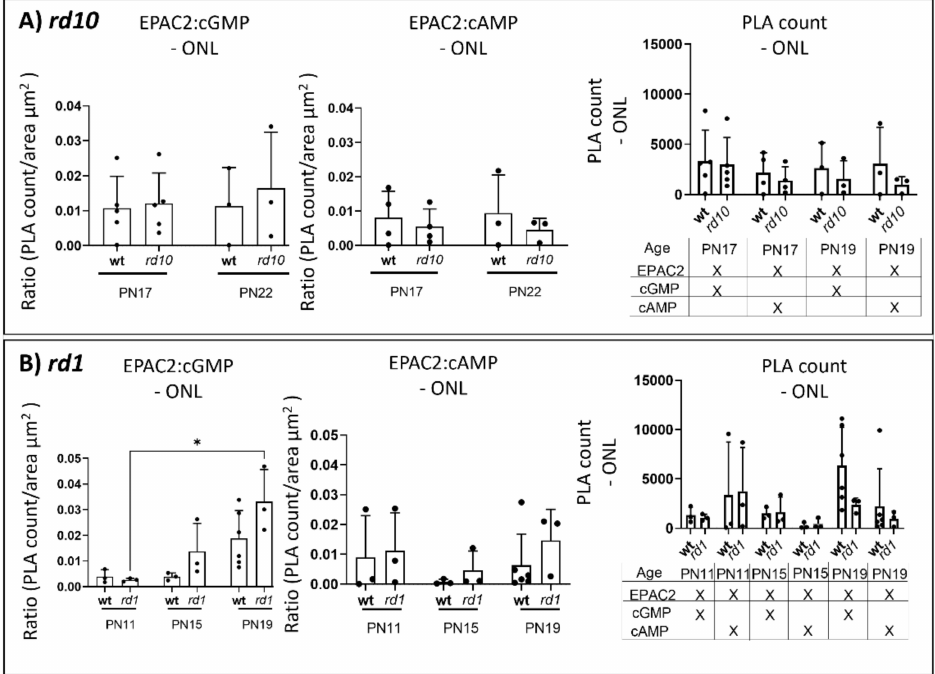
Figure 5. The extent of cGMP and EPAC2 proximity increases with time in the rd retina. Panel ( A , B ) gives PLA ratios (PLA counts over ONL area) and raw PLA counts for various situations: (left) proximity outcome between EPAC2 and cGMP (EPAC2:cGMP); (middle) proximity outcome between EPAC2 and cAMP (EPAC2:cAMP); (right) the raw proximity count (PLA count) was provided for comparison. ( A ) rd10 did not show any significant alteration between EPAC2:cGMP nor between EPAC2:cAMP at PN17 or PN22. ( B ) A significant increase in the EPAC2:cGMP ratio was observed over time in the rd1 model. Graphs represent three to six biological replicates, and bars represent mean ± SD; levels of significance are: * p < 0.05. ONL: outer nuclear